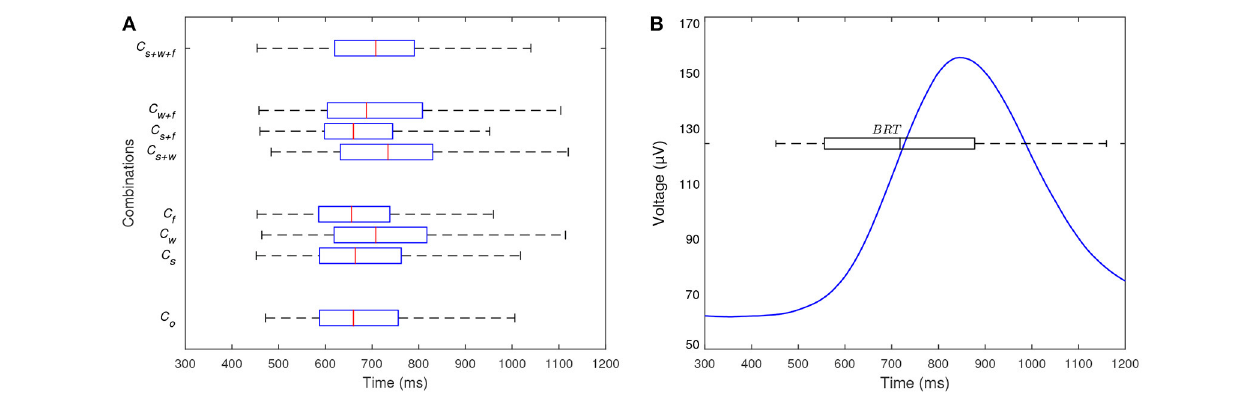
FIGURE 5 | (A) Distributions of BRT across all participants for each experimental combination. At least one of the distributions is significantly different which indicates different BRT across the experimental combinations. (B) Time-resolved LEG signal averaged across all participants for all experimental combination. The distribution of BRT across all participants and experimental combination is also shown. The reference time t = 0 correspond to the stimulus. The LEG signal begins to increase at ∼ 600 ms (i.e., prior to the median BRT) and peaks at ∼ 850 ms.